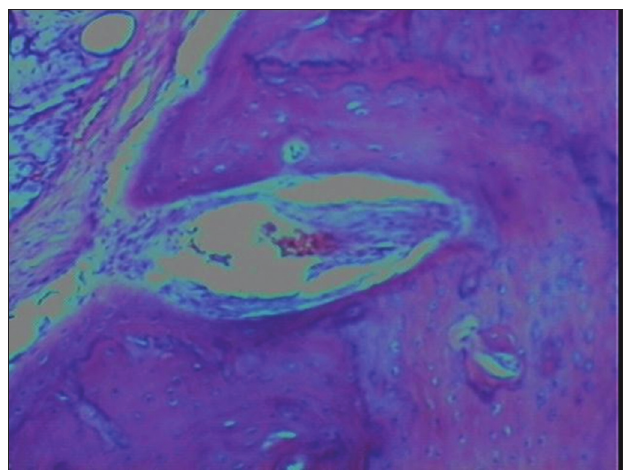
Table 1. New bone formation analysis in the area morphometry in the control and hydroxyapatite